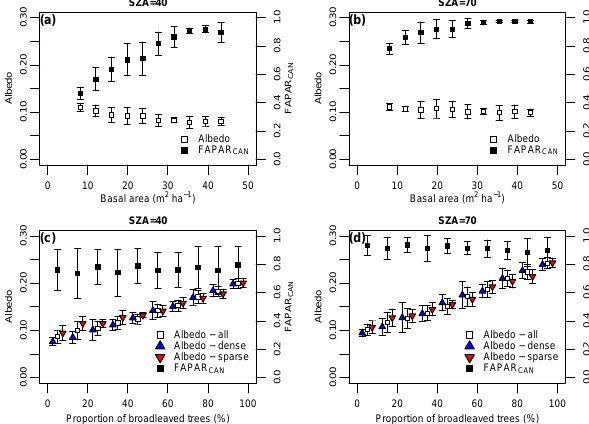
Figure 9. Effect of basal area (a–b) and proportion of broadleaved trees (c–d) on black-sky albedo and FAPAR CAN at sun zenith an- gles of 40 and 70 ◦ in Alaska. Points represent mean and whiskers the standard deviation in 10 equally spaced classes. Effect of broadleaved proportion on albedo is presented separately for dense (basal area >31m 2 ha − 1 ) and sparse (basal area <21m 2 ha − 1 ) for- est. These limits correspond to 30th and 70th percentiles of basal area in Alaskan data. The points representing dense and sparse for- est are shifted along the x axis in order to make them